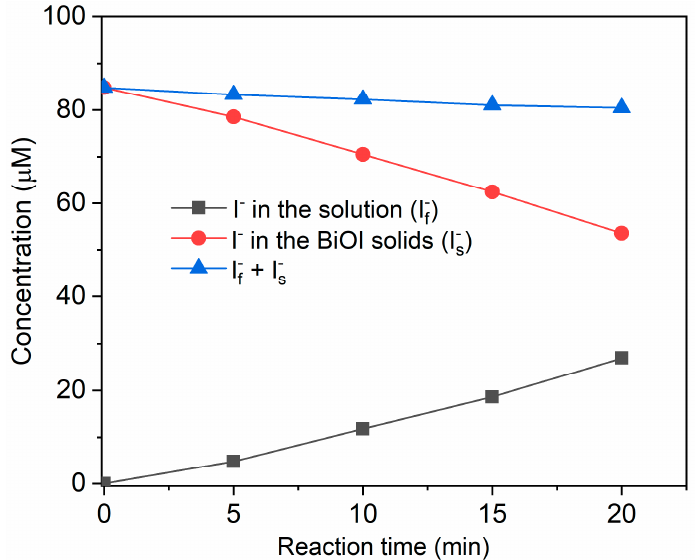
Figure 7. Iodine distribution in the solution and in the BiOI solids during the degradation process. Conditions: [BiOI] 0 = 1.0 g ⋅ L − 1 (84.9 μ M as I); [S(IV)] 0 = 1.0 mM; [MCAA] 0 = 10 μ M; [DO] 0 = 0.22 mM (7.1mg ⋅ L − 1 ); pH = 7.0, 25 ± 1 °C.